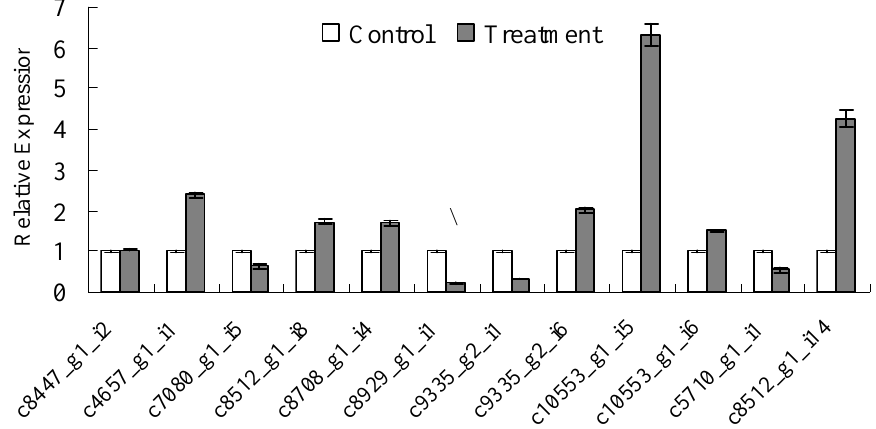
Figure 3. Quantitative real-time PCR validation of differentially expressed unigenes in the P. betulinus transcriptome. All reactions were performed in biological triplicate, and the error bars represent the standard deviations. This figure included c8447_g1_i2, c9355_g2_i6 β - D -Glucosidase; c10553_g1_i6, c10553_g1_i5, β -mannosidase; c8512_g1_i14, c8512_g1_i8, pectinesterase c4657_g1_i1, c8708_g1_i4, α -glycosidase; c7080_g1_i5, c8929_g1_i1,polygalacturonase; c9335_g2_i1 and c5710_g1_i1 [3-(3-hydroxy-phenyl) propionate